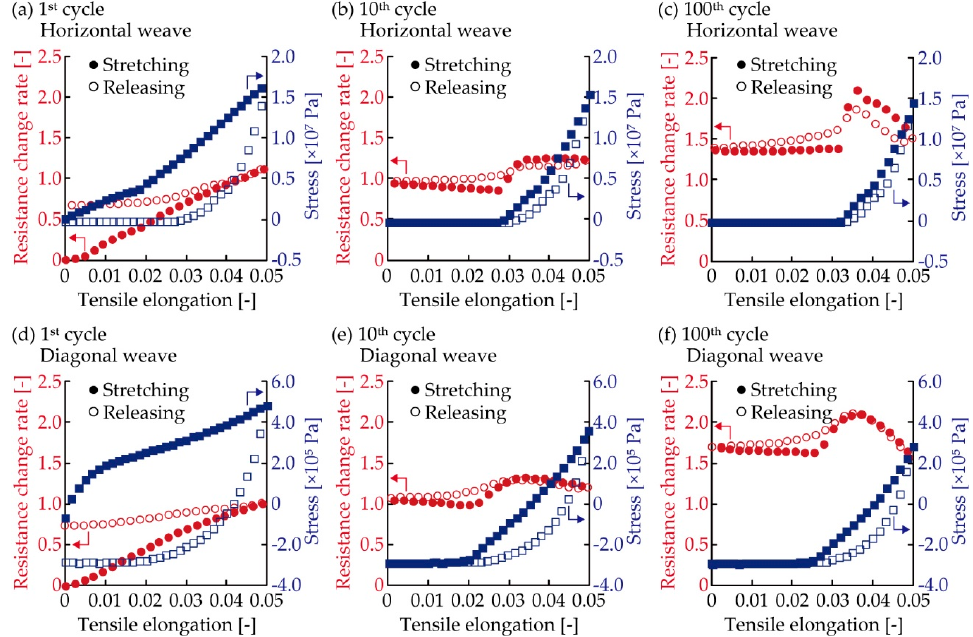
Figure 6 Resistance and stress variation for one of the samples with 1.4 mm-wide conductive patterns. Horizontal weave during ( a ) 1 st , ( b ) 10 th , and ( c ) 100 th cycle. Diagonal weave during ( d ) 1 st , ( e ) 10 th , and